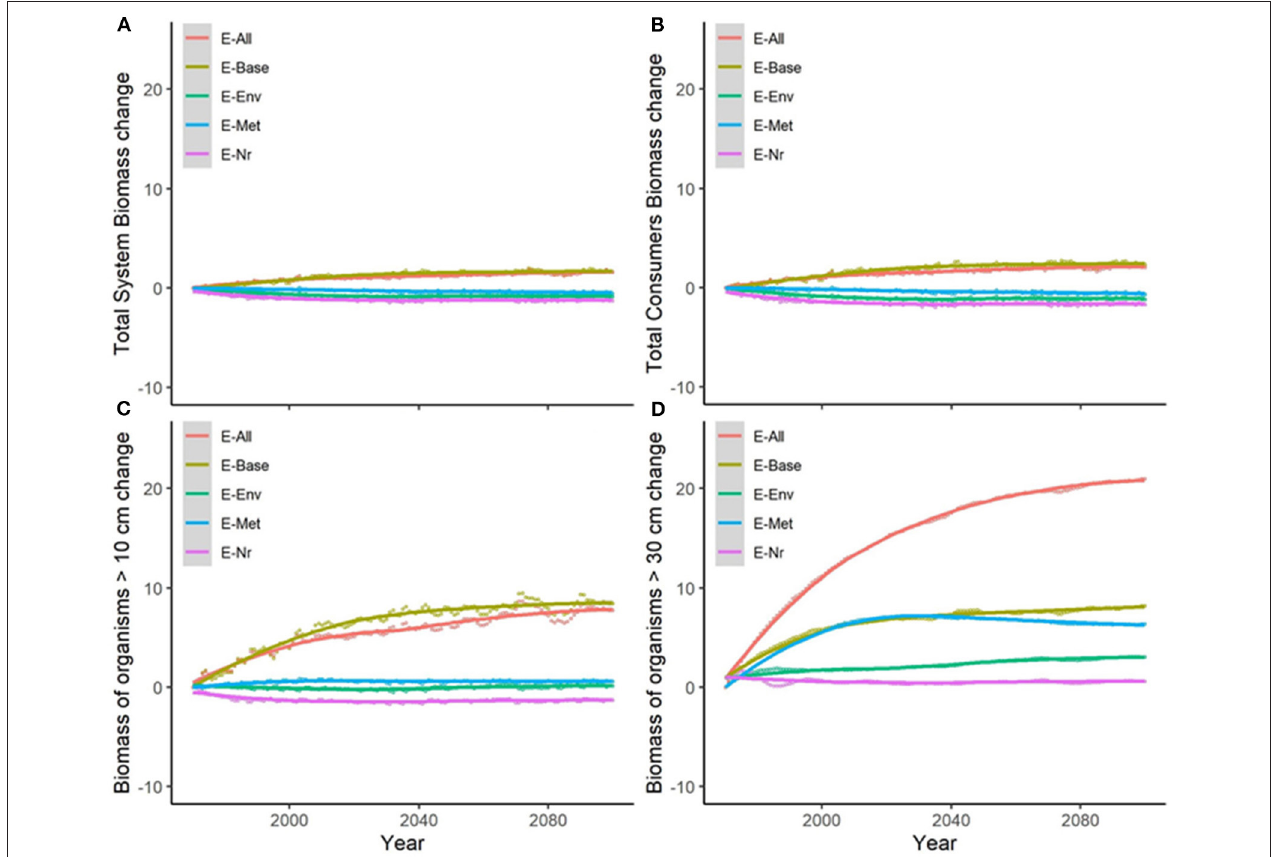
Supplementary Figure 6 shows results for Biomass of commercial